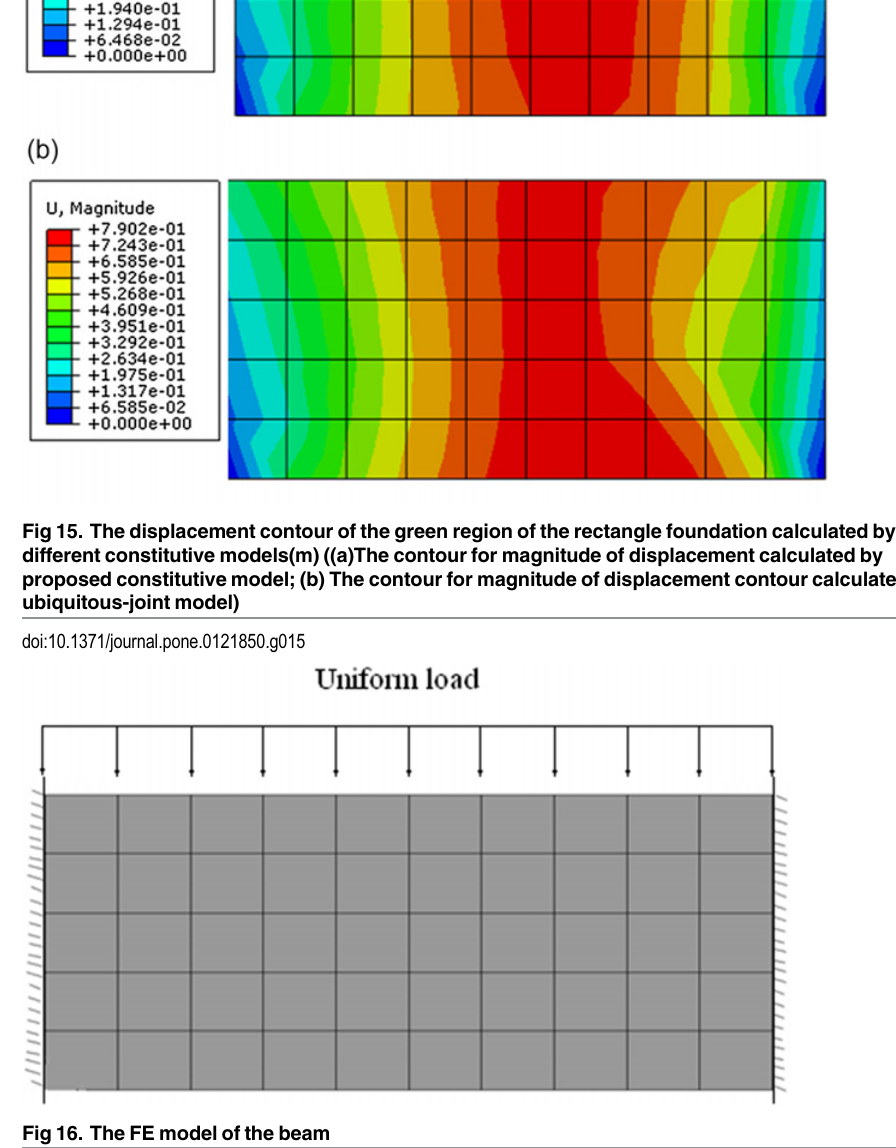
Fig 16. The FE model of the beam